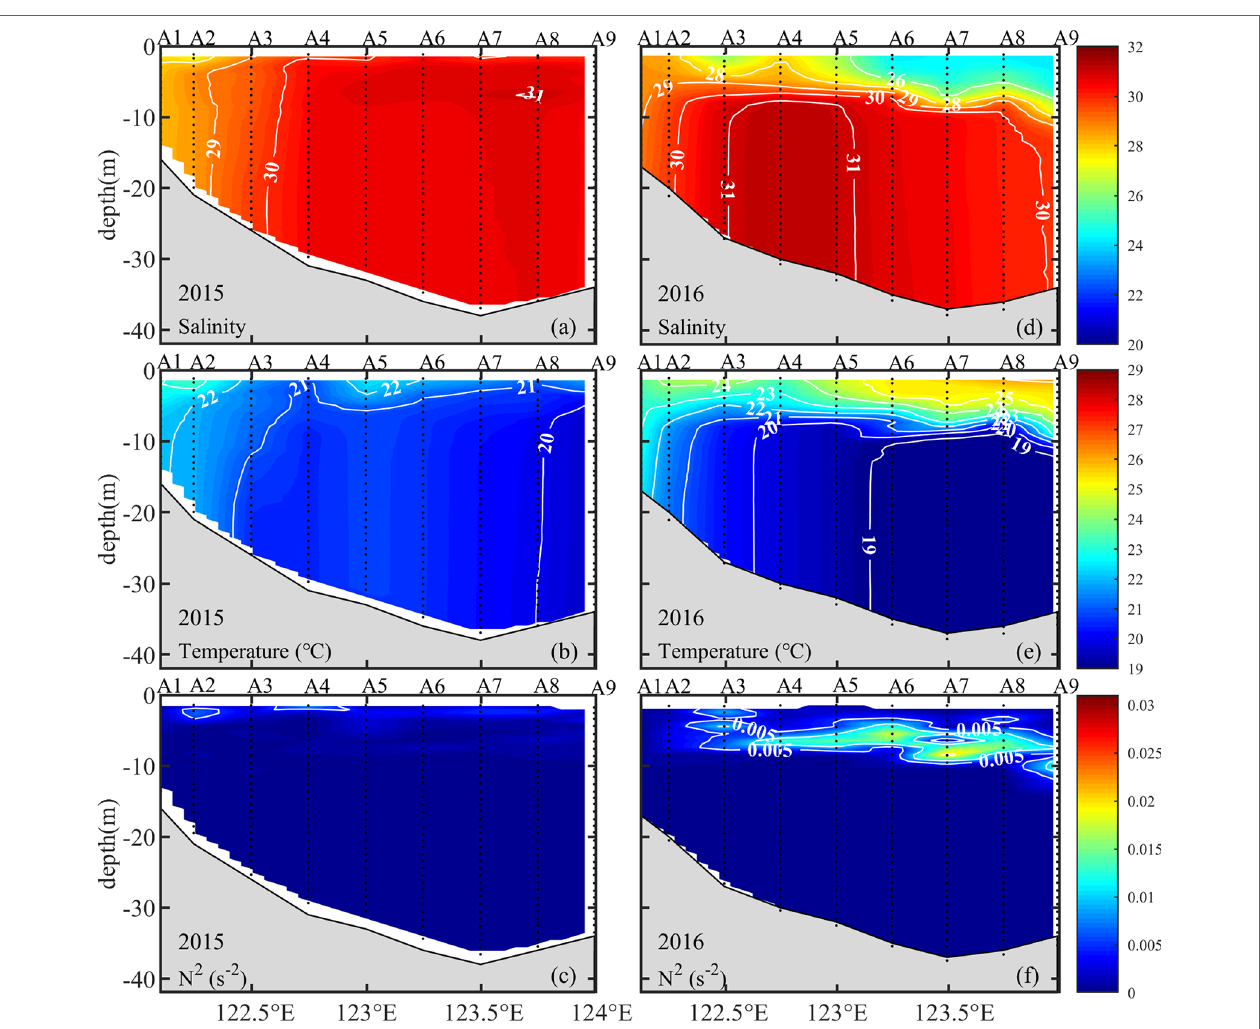
FIGURE 3 | Vertical distributions of salinity (A, D) , temperature (B, E) , and squared buoyancy frequency (C, F) along Transect A (32.25°N) in summer of 2015 (A-C) and 2016 (D-F)